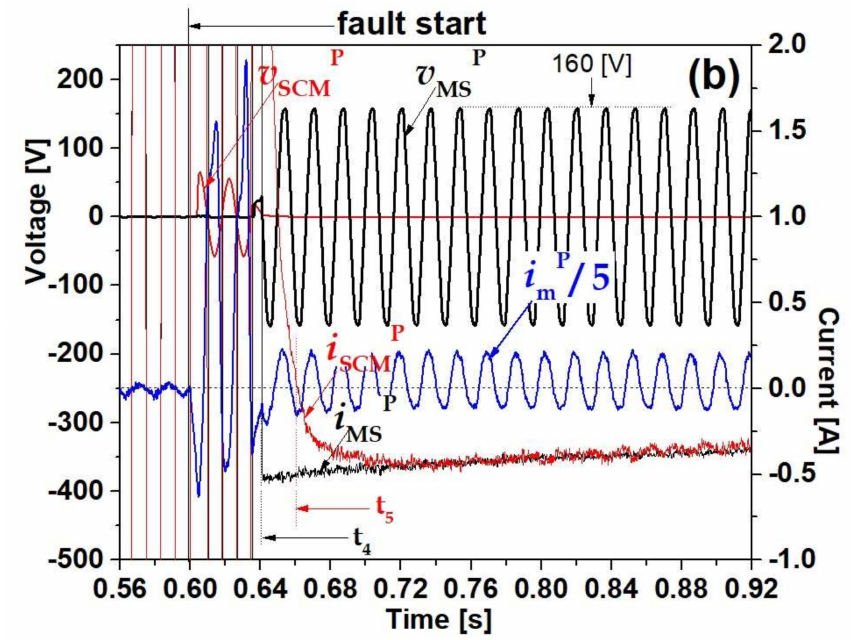
Figure 8. Voltage and current waveforms of the SCM, MS and magnetizing branch ( v SCM , v MS , i SCM , i m ) for the breaking time analysis of the SFCLB using flux coupling after the fault occurrence. ( a ) Series connection. ( b ) Parallel connection.